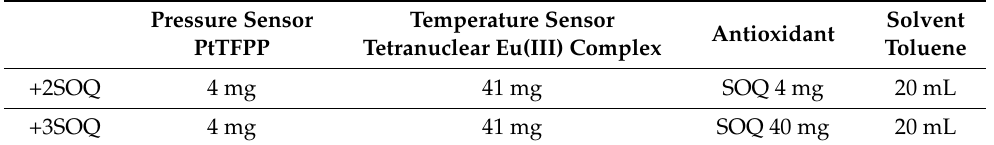
Table 4. Dye solutions for additional tests.